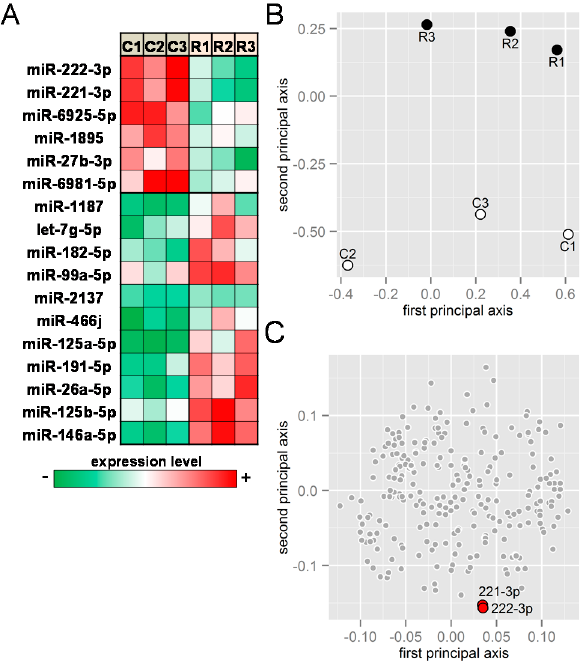
Figure 1. Microarray-based miRNA expression analysis. Cells were stimulated with 20 ng/mL RANKL for two days. ( A ) Heat map of the selected miRNAs (signal values < 500 and p < 0.05) in response to receptor activator of nuclear factor κ -B ligand (RANKL). The green and red colors indicate downregulation and upregulation, respectively. Of note, C1, C2, and C3 are control samples, and R1, R2, and R3 are RANKL-treated samples; ( B ) Principal component analysis (PCA) for six samples (C1–C3, and R1–R3) in the first and second principal plane; and ( C ) PCA for miRNAs in the first and second principal plane. Two miRNAs (221-3p and 222-3) are positioned with the smallest values along the second principal axis.